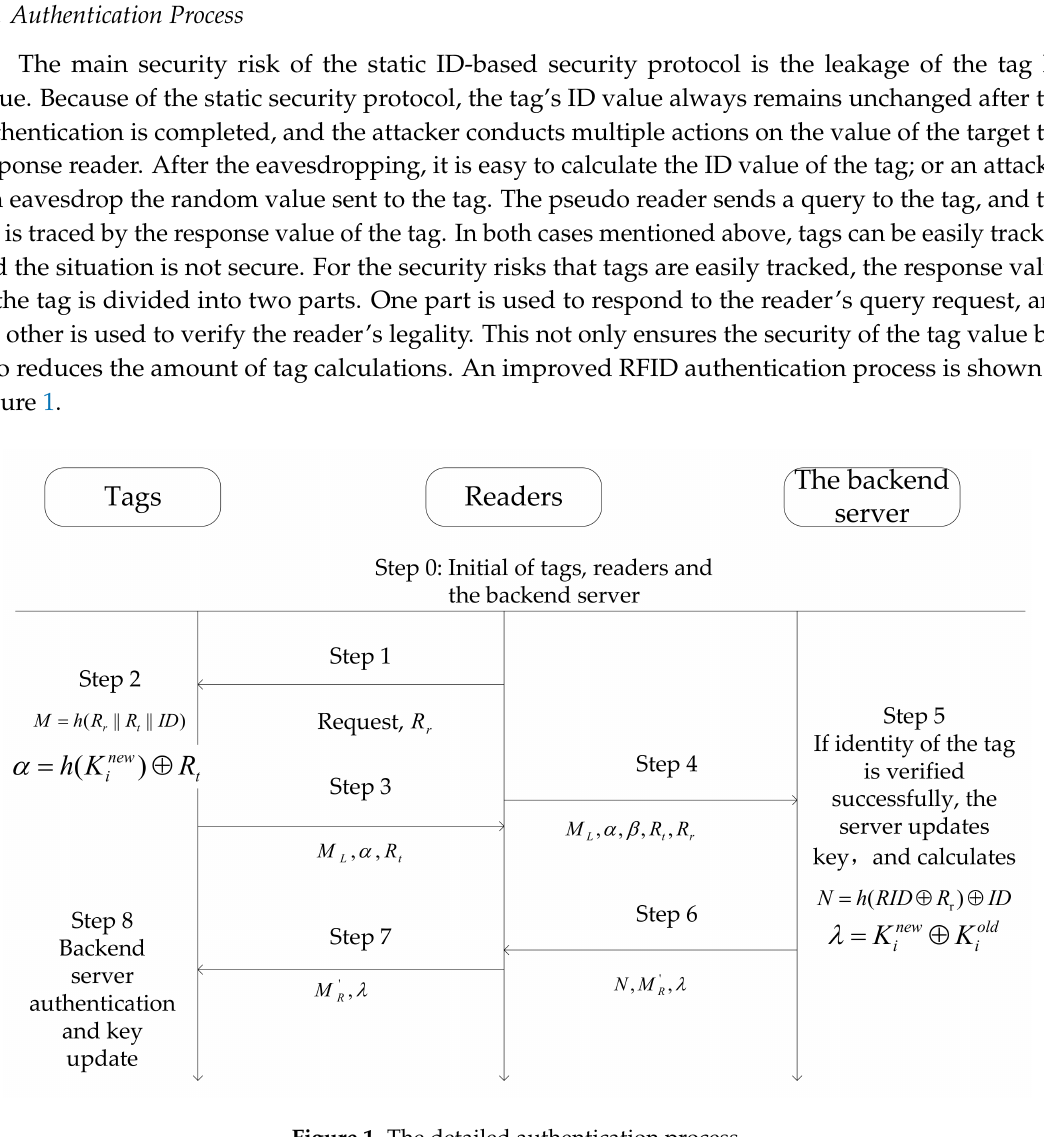
Figure 1. The detailed authentication